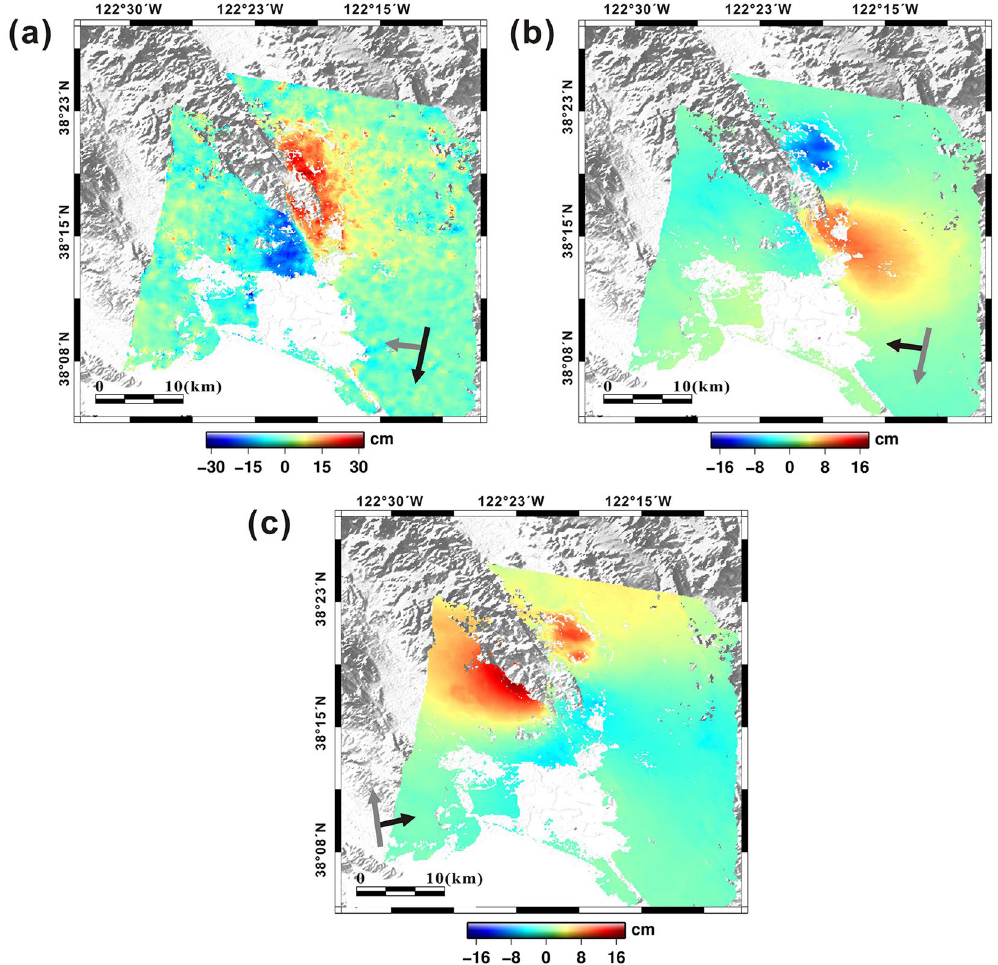
Figure 2. Maps of ( a ) along-track and ( b ) cross-track (LOS) displacements from CSK descending data between 26/07/2014 and 27/08/2014, and ( c ) cross-track displacements from CSK ascending data between 19/06/2014 and 03/09/2014. The displacement maps were generated by the GMT software 5.3.2 version (http://gmt.soest.